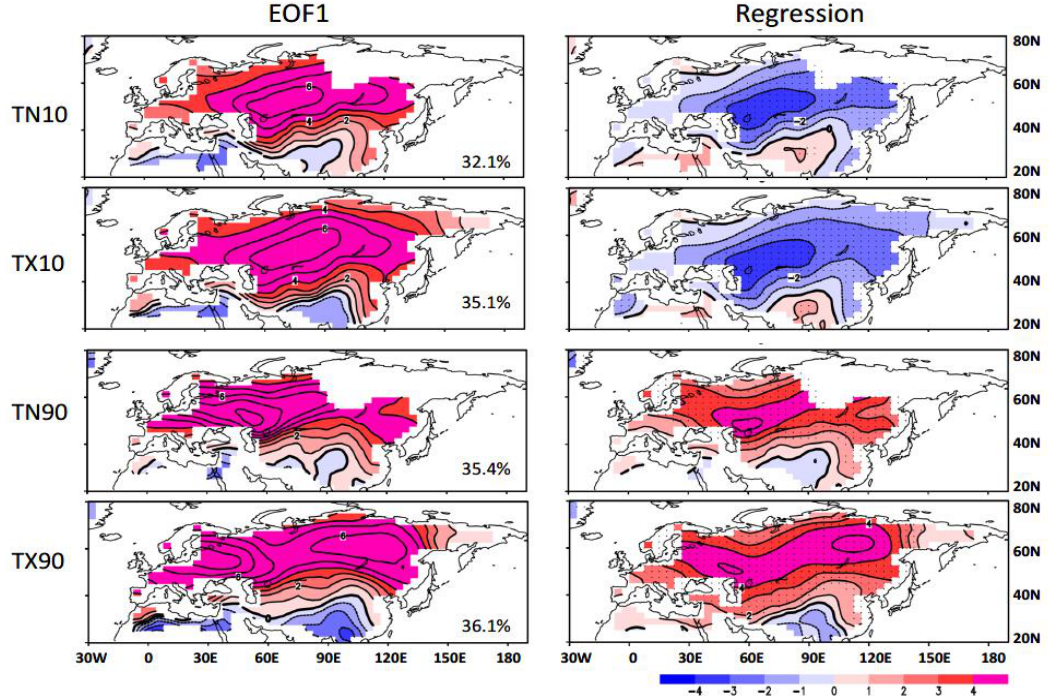
Figure 7. ( left ) EOF1 of JFM extreme temperature anomalies over Eurasia. The percentage of total variance explained by EOF1 is given in the lower right corner of each plot. ( right ) Regressions of JFM extreme temperature anomalies onto the linearly de-trended and standardized ensemble mean cyclone count series over the period 1951 – 2010. Black dots indicate anomalies that are significantly different from zero at the 5% level. Results of TN10, TX10, TN90, and TX90 are shown from top to bottom. Contour interval is 1.0 °C.